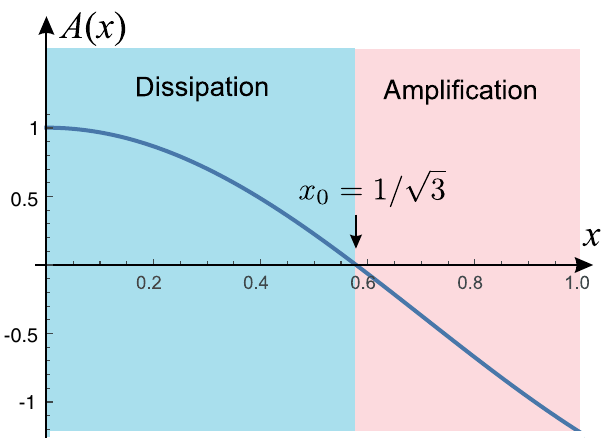
FIG. 15. The amplitude of the dissipation as a function of x ¼ V 1 =s 1 . Dissipation-amplification transition corresponds to ffiffiffi p 3 x ¼ x 0 ¼ 1 =